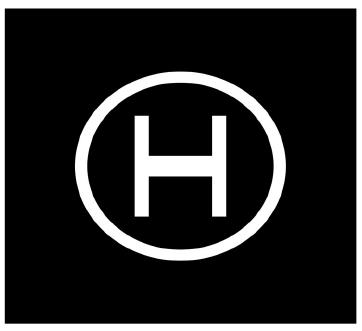
Figure 4. Designation of the target.